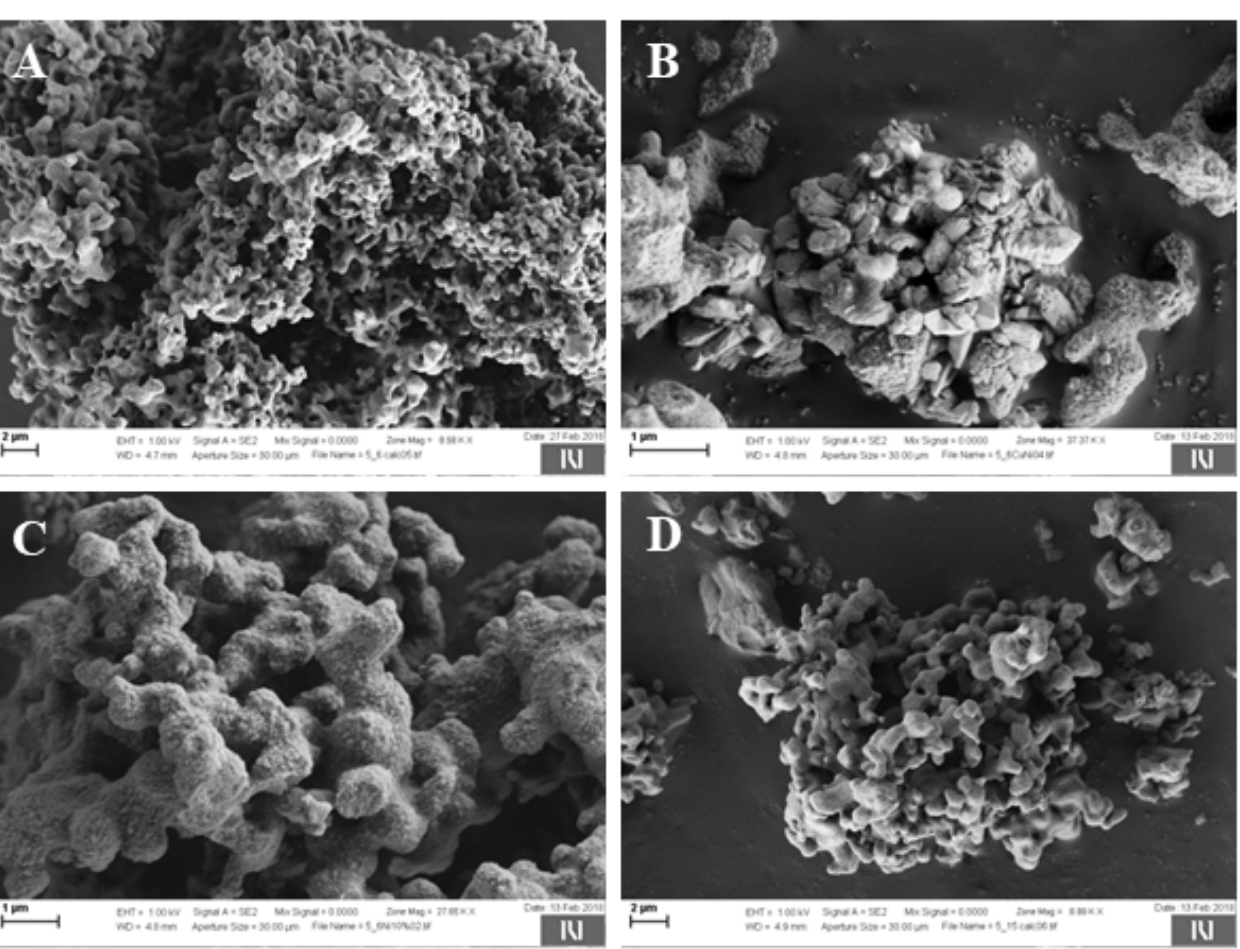
Figure 3. SEM micrographs of studied catalysts: parent KZ ( A ); CuNi-KZ ( B ); Ni-KZ ( C ); Cu-KZ ( D ).